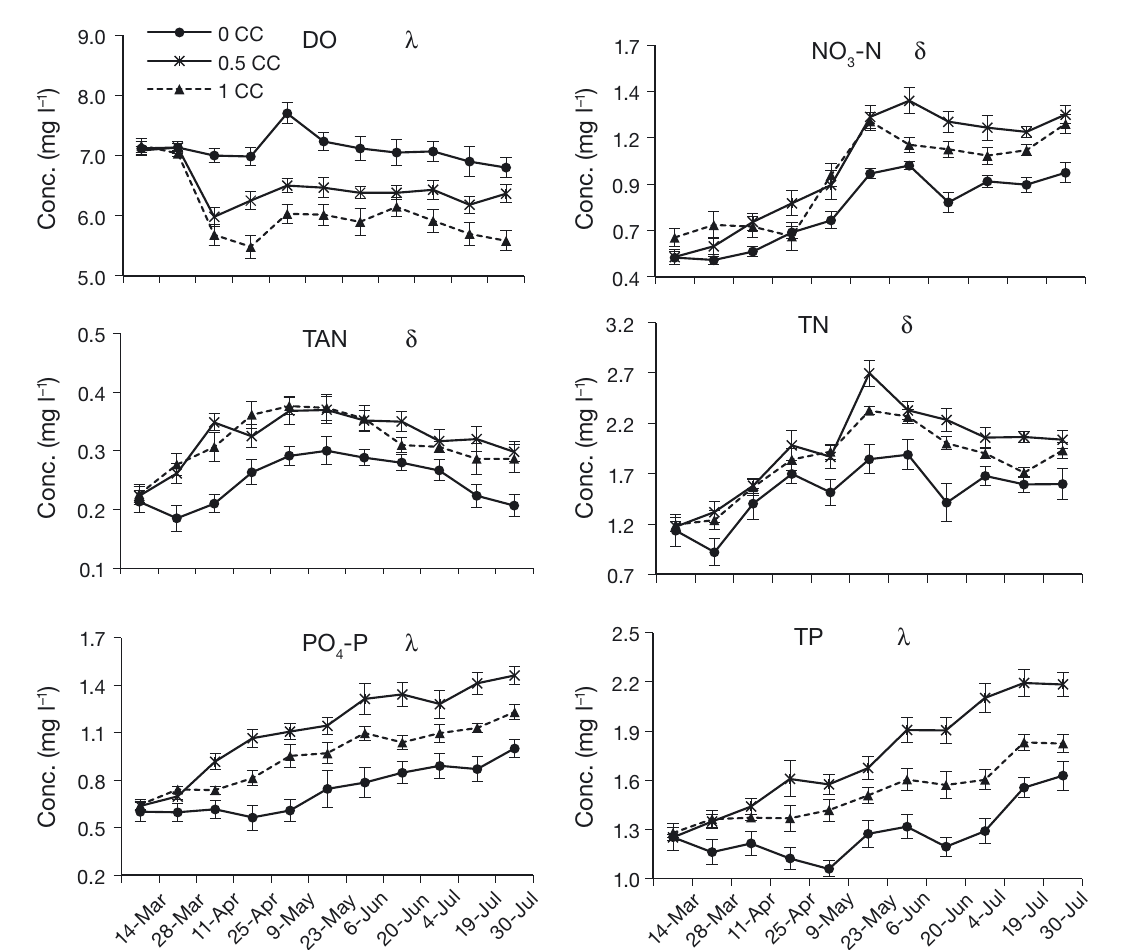
Fig. 1. Interaction between time and common carp (CC; Cyprinus carpio) density on the changes in different environmental parameters. Data are means (±SE). 0 CC, 0.5 CC and 1 CC indicate the ponds without common carp, with 0.5 common carp m −2 , and with 1 common carp m −2 , respectively. δ indicates the significant difference (p < 0.01) between the ponds with com- mon carp and without common carp. λ indicates that the ponds without common carp, ponds with 0.5 common carp m −2 , and the ponds with 1 common carp m −2 are significantly different from each other (p < 0.05). See Table 1 for